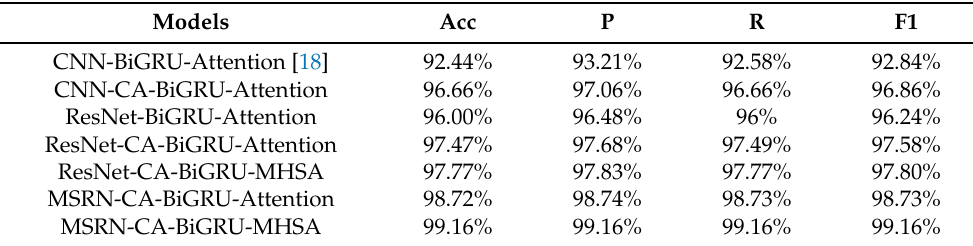
Table 5. Experimental results of the Oriental language identification dataset.